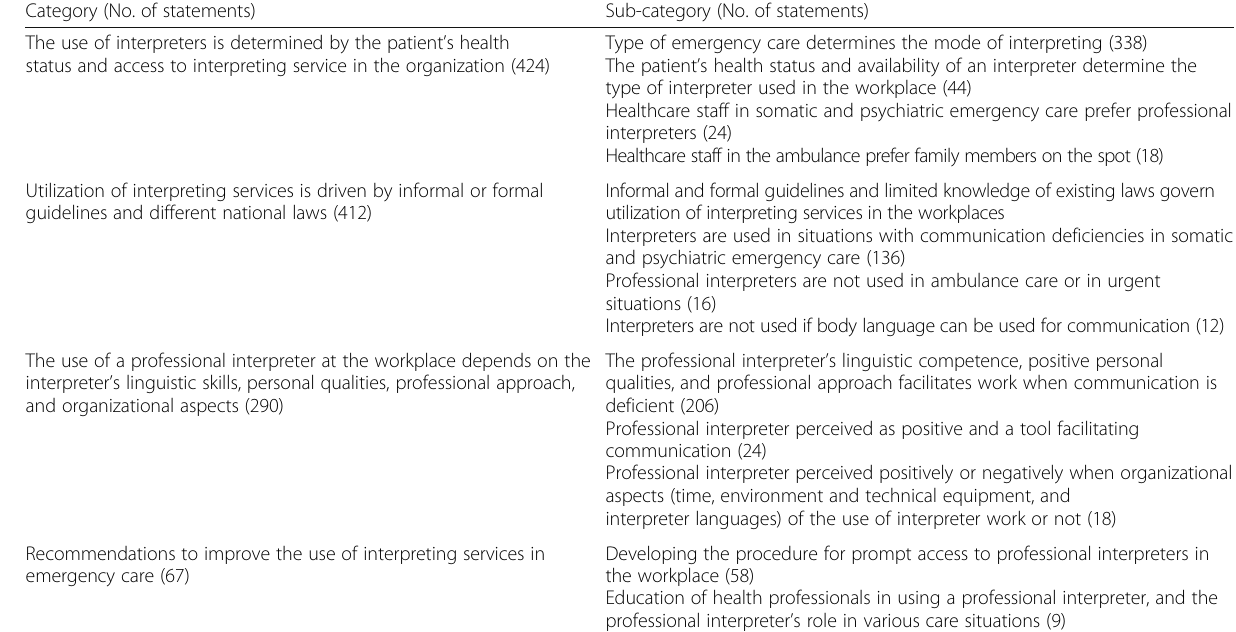
Table 2 Overview of categories with subcategories analyzed from interviews by healthcare staff working in multilingual emergency